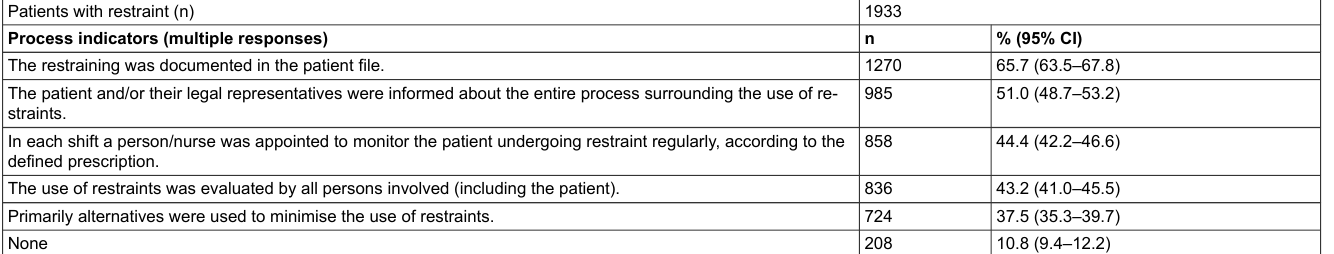
Table S5: Processes surrounding restraint